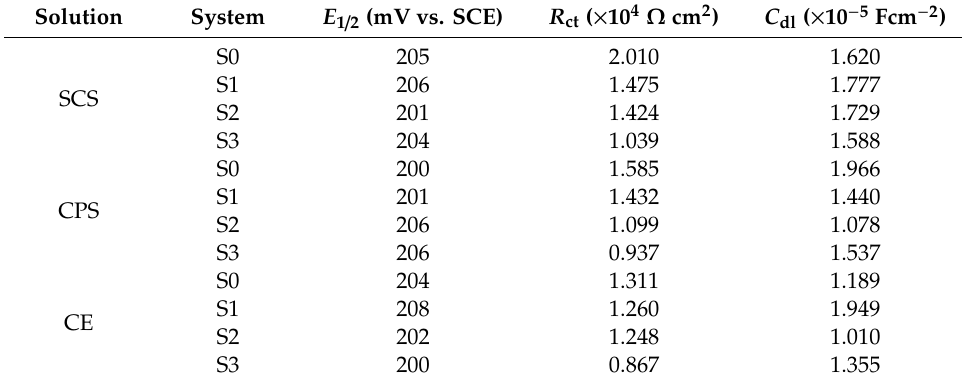
Table 4. Parameter of AC impedance for MnO 2 sensor embedded in concrete [94]. Reproduced with permission from ref. [94]. Copyright 2008 Elsevier.